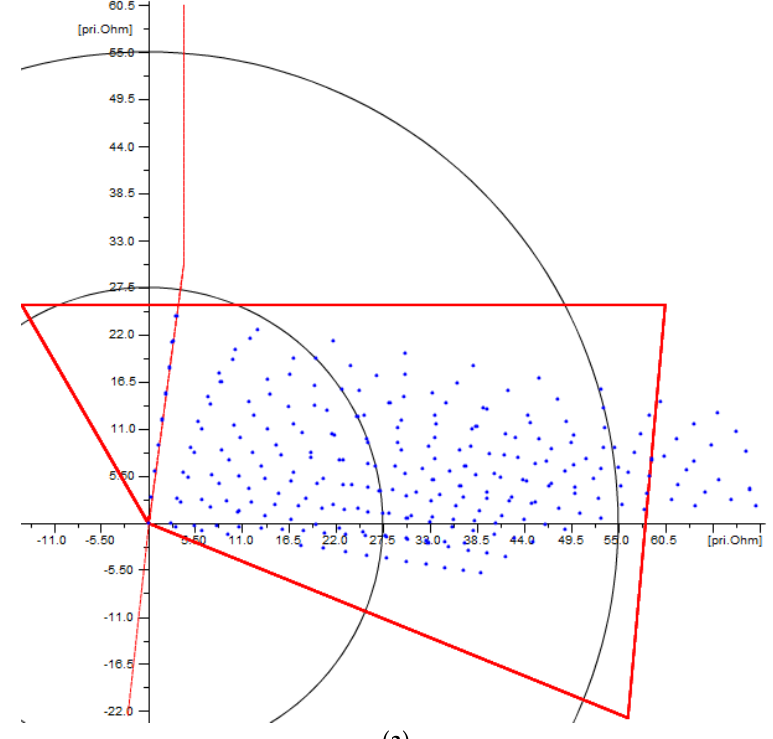
Figure 11. Initial Zone 1 settings and measured loops for single-phase-to-ground and three-phase faults grouped in ( a ) set D 1 for Zone 1 calculation, and ( b ) set F 1 for Zone 1 calculation.